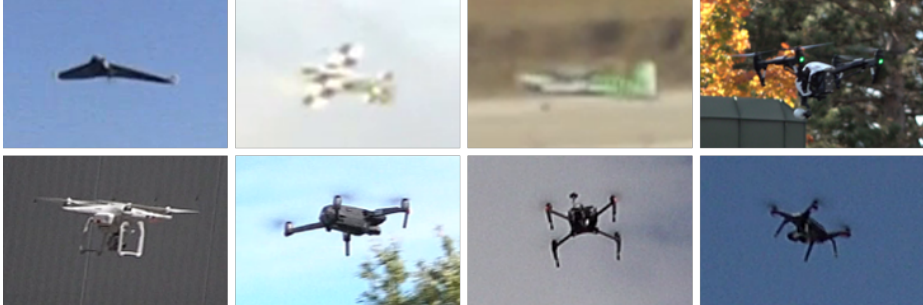
Figure 1. Examples of drone types present in the dataset, i.e., Parrot Disco, 2 custom fix wing drones, DJI Inspire, DJI Phantom, DJI Mavic, DJI Matrice and 3DR Solo